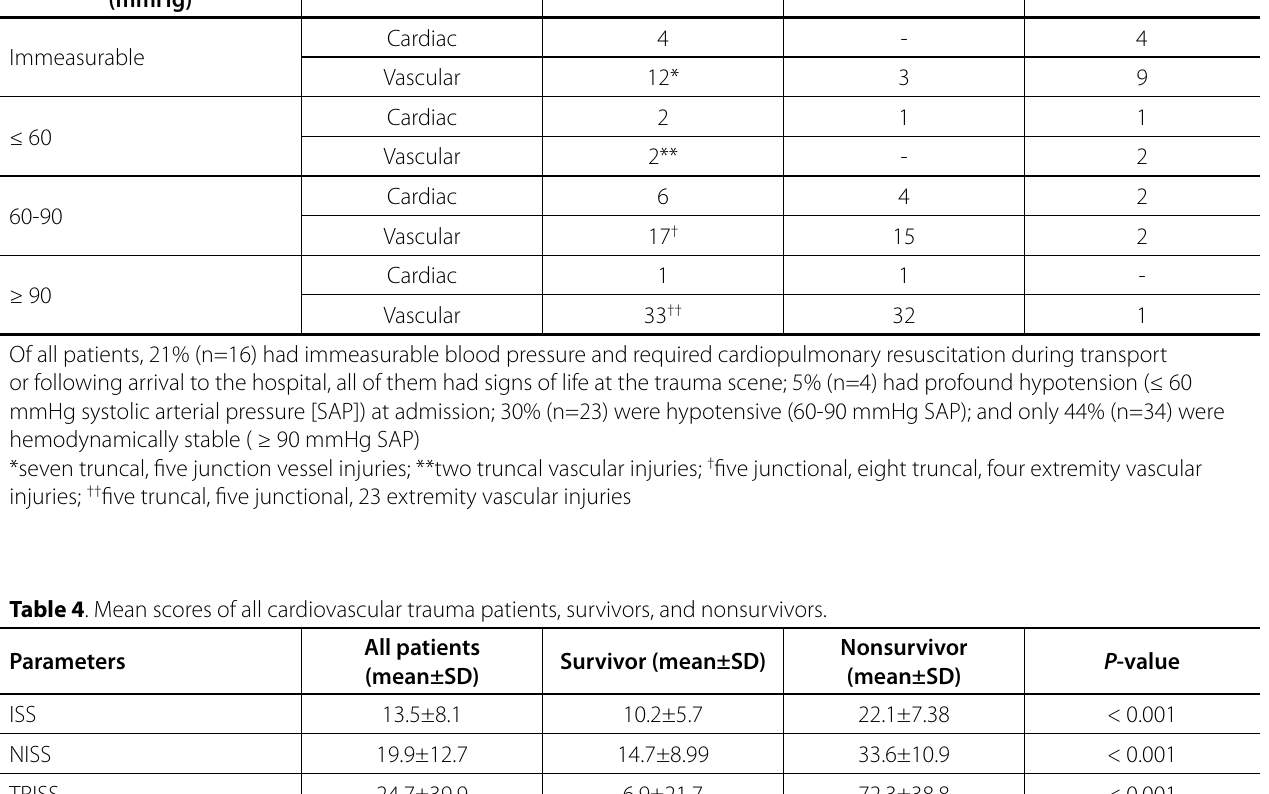
The significance of scores for prediction of mortality is analyzed using Mann-Whitney U test ISS=Injury Severity Score; NISS=New Injury Severity Score; RTS=Revised Trauma Score; SD=standard deviation; TRISS=Trauma